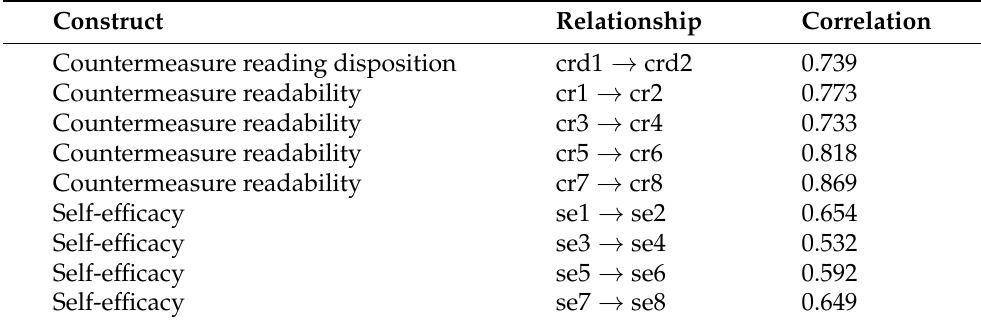
Table 2. Correlations of formative indicators. Note that correlation is a bidirectional